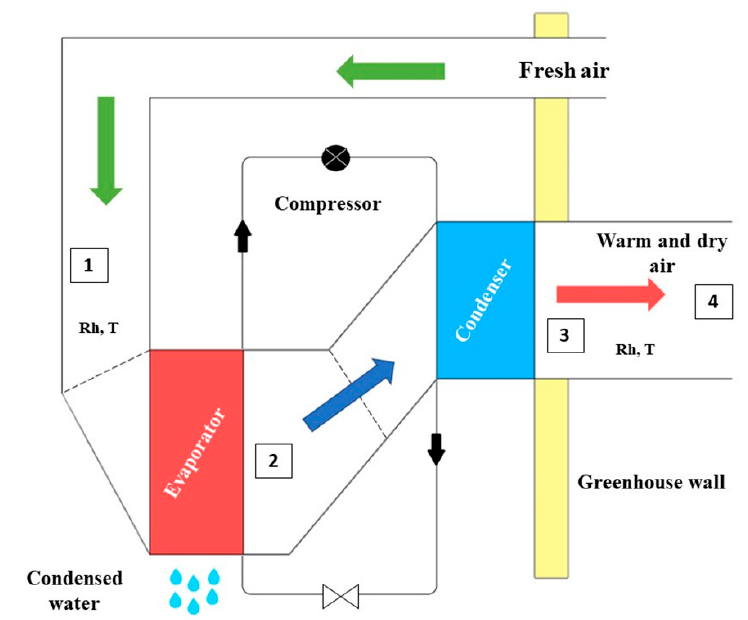
Figure 4. Schematic representation of a dehumidifying heat pump for a greenhouse (Modified from Chantoiseau et al. [172]). 528